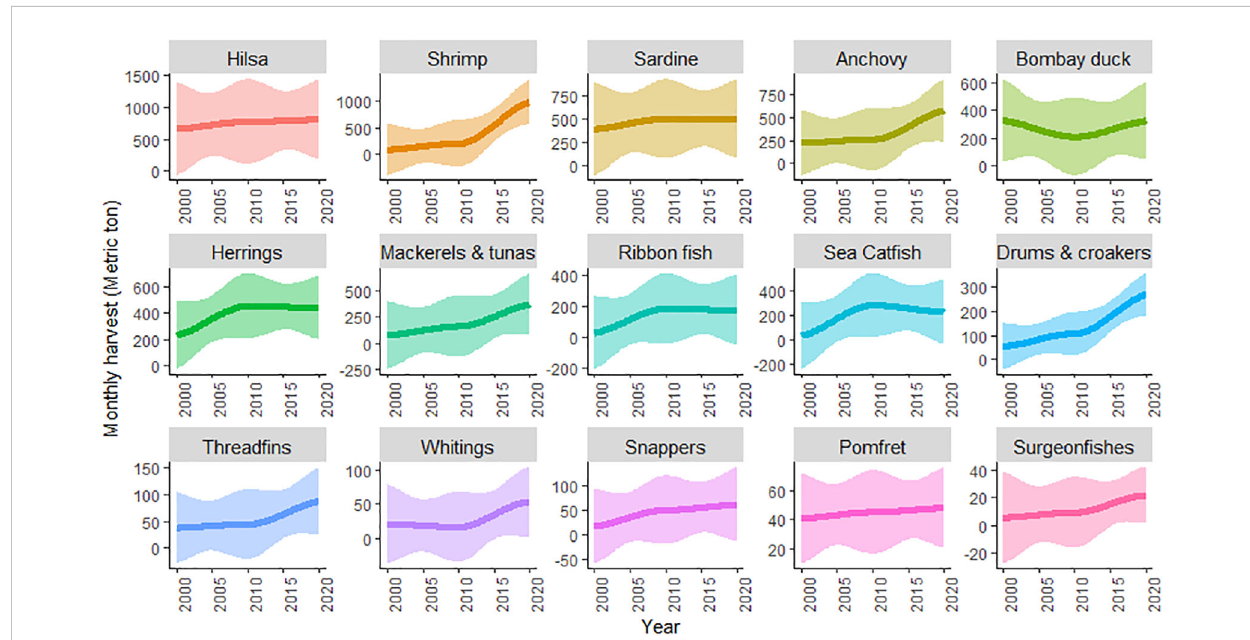
FIGURE 3 Total relative landed catches per month per landing center in the Bay of Bengal small-scale marine fi shery from 2000 to 2020. The solid line is the smooth function estimate and shaded regions represent 95% con fi dence interval (CI). Source: Fishers ’ FGD data.